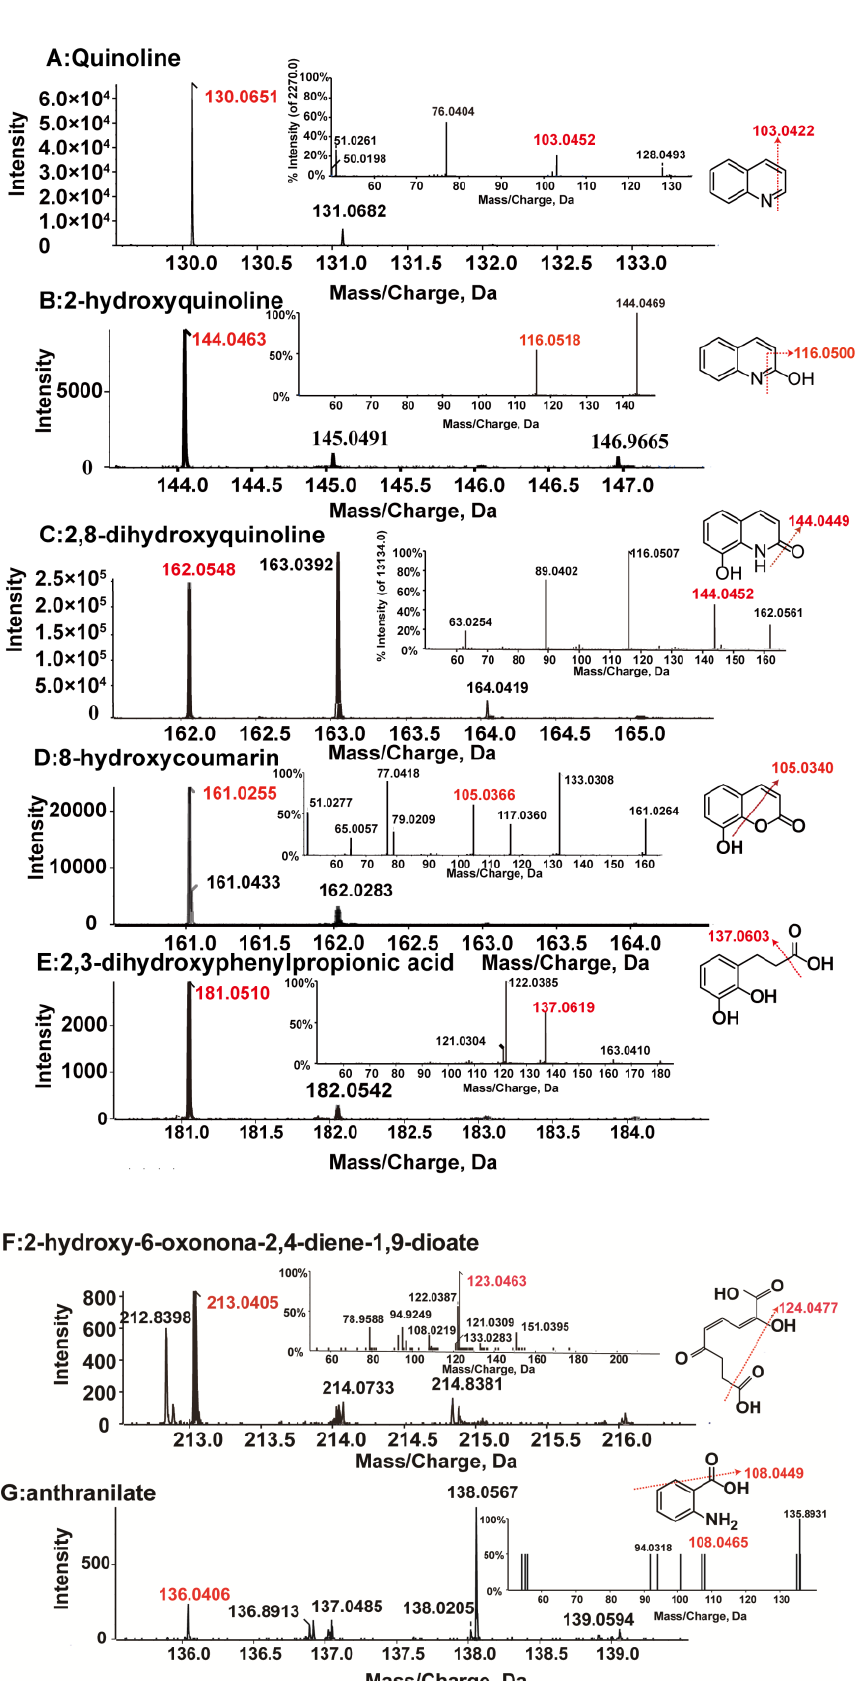
Figure 4. HPLC – MS mass spectrograms and proposed structures of quinoline and its metabolites. Figure 4. HPLC–MS mass spectrograms and proposed structures of quinoline and its Although only one visible peak emerged in HPLC analyses, several trace amount intermediates were detected by HPLC – MS. As shown in Figure 4, five more metabolites were detected. According to their molecular and fragment ion peaks, these intermediates